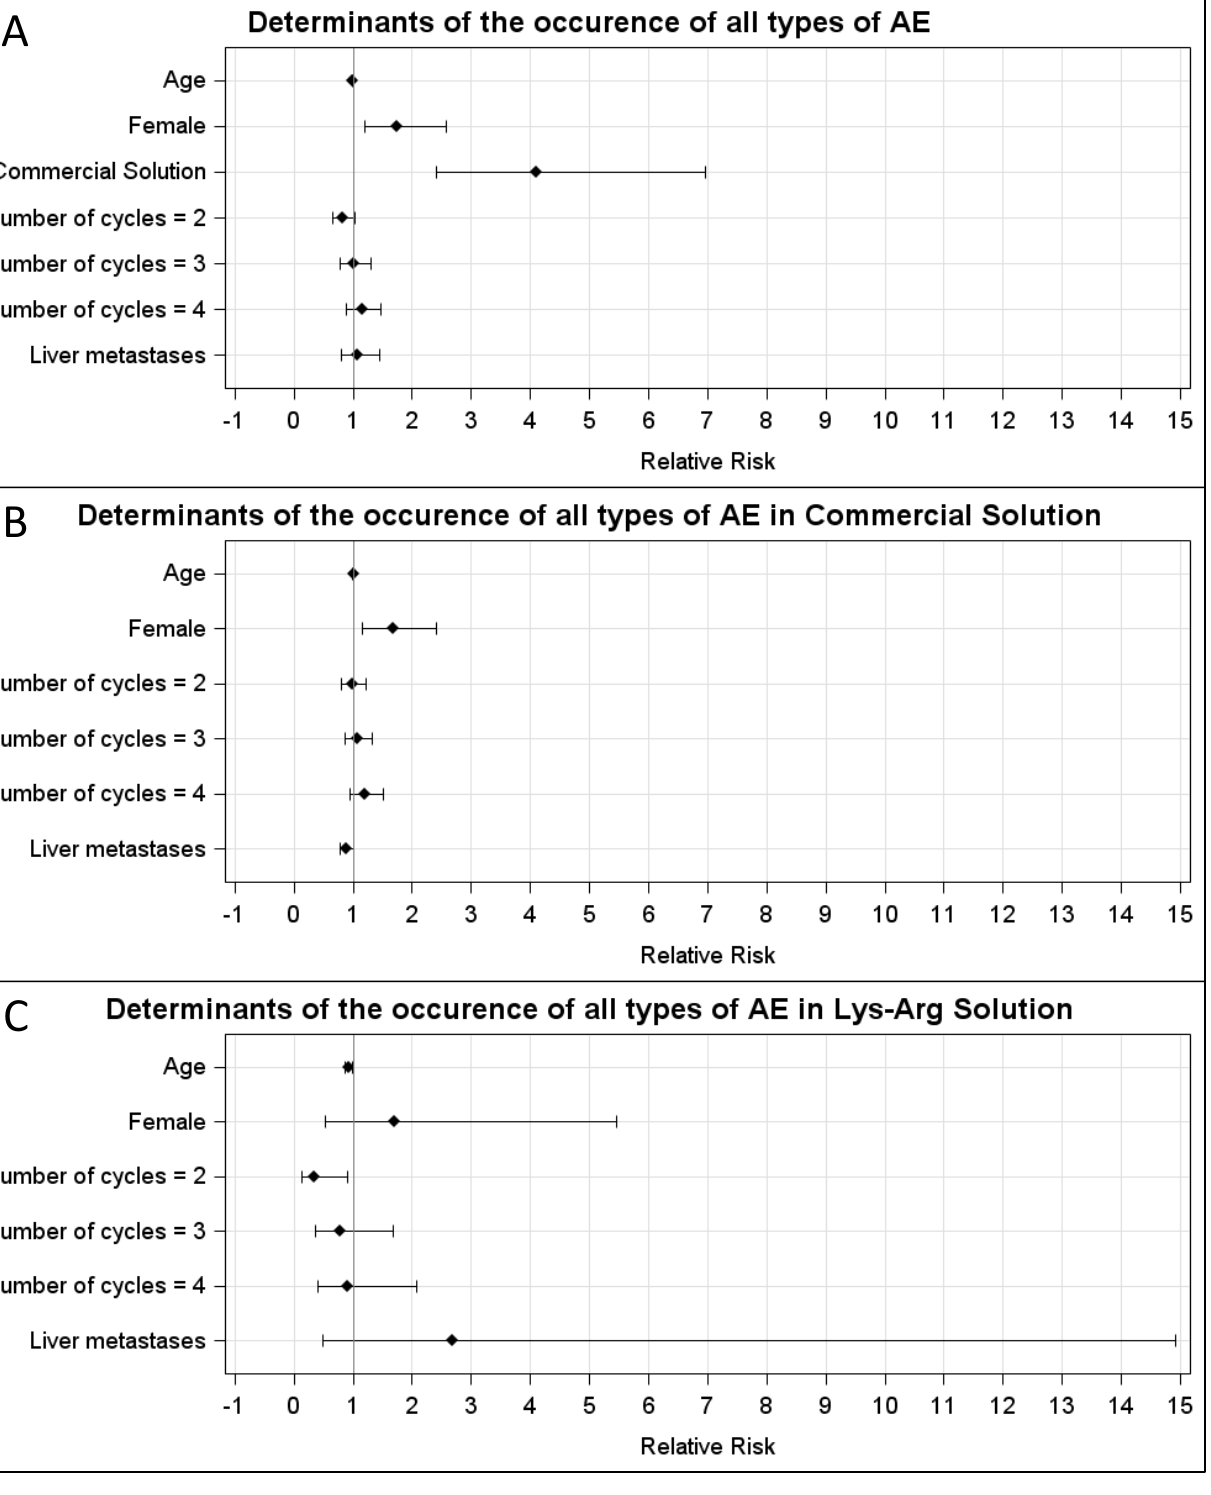
Figure 3. Relative risk calculated with Poisson regression for ( A ) all types of AE in the LysArg group, compared to the CS group; ( B ) all types of AE in the CS only and ( C ) LysArg only. Determinants were age, gender, number of cycles and presence of liver metastasis.